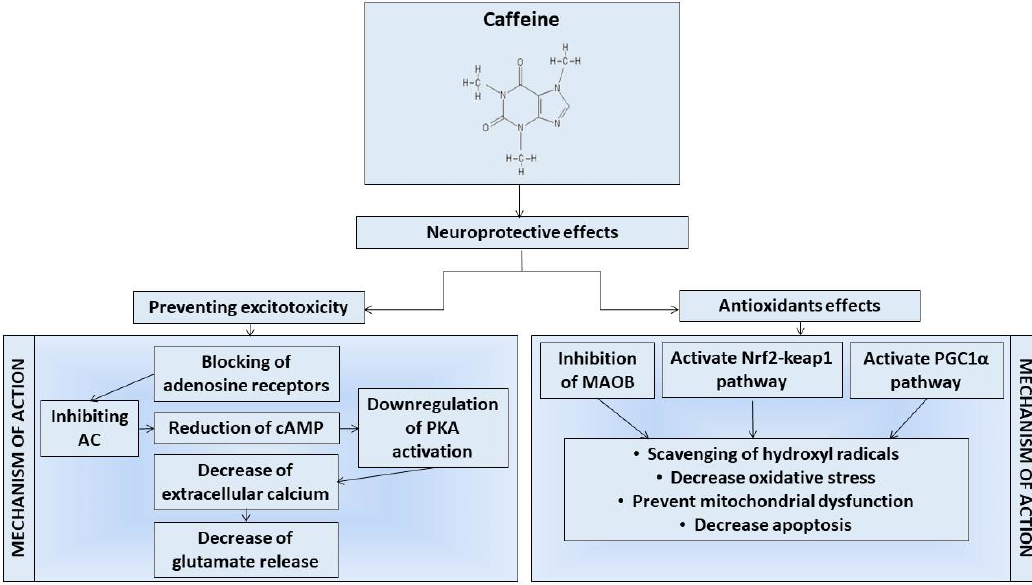
Figure 2. The image graphically summarizes the main mechanisms of action proposed to mediate the neuroprotective effects of caffeine.